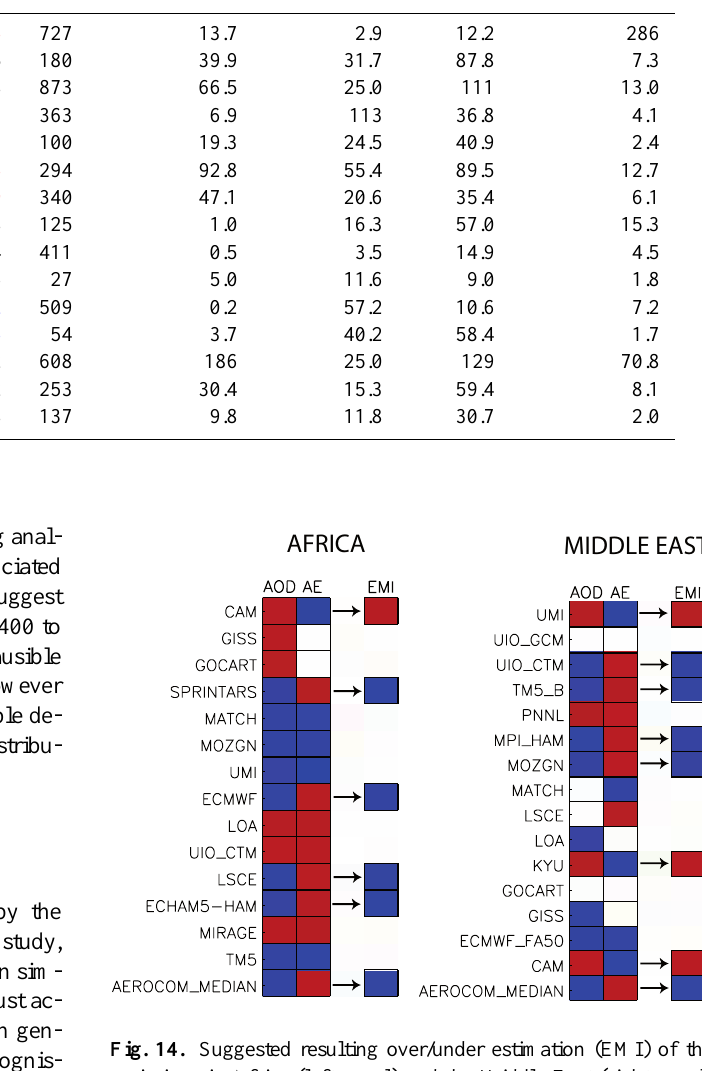
Fig. 14. Suggested resulting over/under estimation (EMI) of the emissions in Africa (left panel) and the Middle East (right panel) based on AERONET Angstr¨om Exponent (AE) and aerosol optical depth (AOD). Simultaneous overestimation of the AOD and under- estimation of the AE suggests an overestimation of the emissions and vice versa. Overestimations in a given model are illustrated by red color, whereas underestimations are indicated by blue